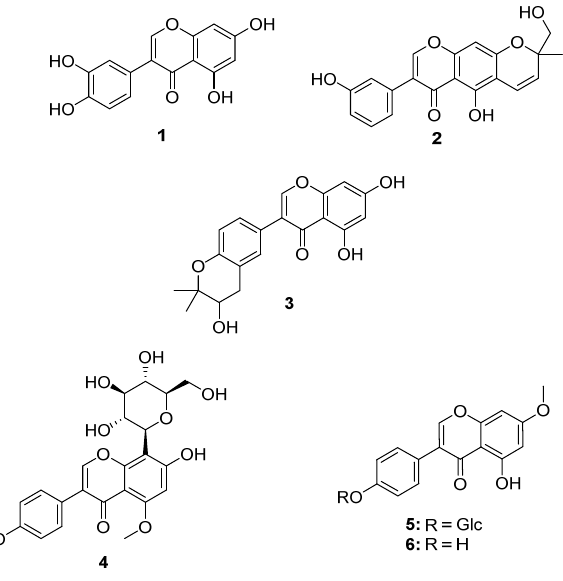
Figure 2. Putative structures of identified compounds.